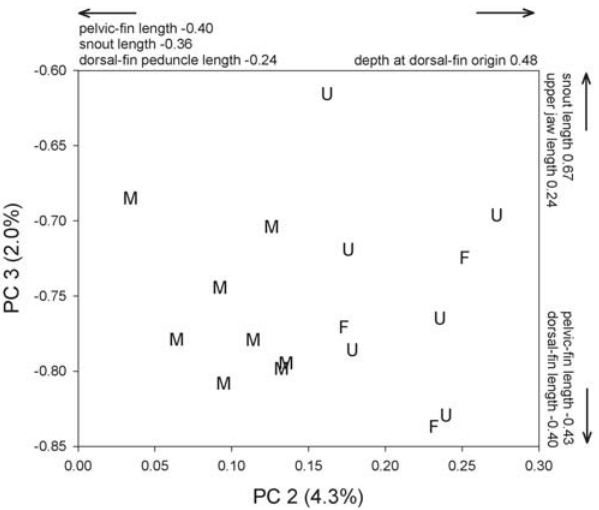
Fig. 29. Principal component analysis of the 18 morphometric data of males (M), females (F), and unsexed specimens (U) of Odontostilbe parecis . Stronger loadings on the second and third principal components (PC2, PC3).